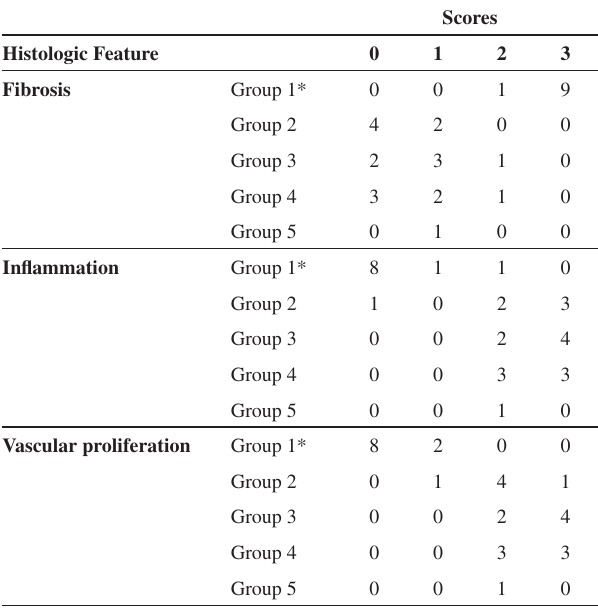
Table 3 - Histologic features of biopsies from adhe- sions 6,7,28